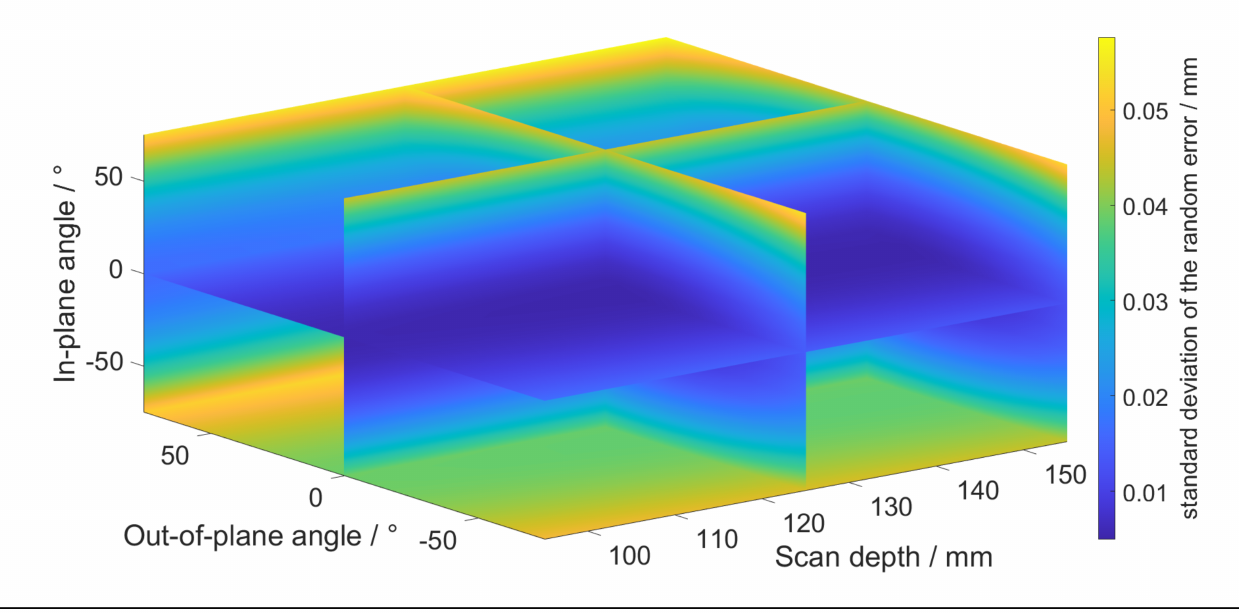
Figure 11. The random error of the LLS for stainless steel surfaces in function of the measurement